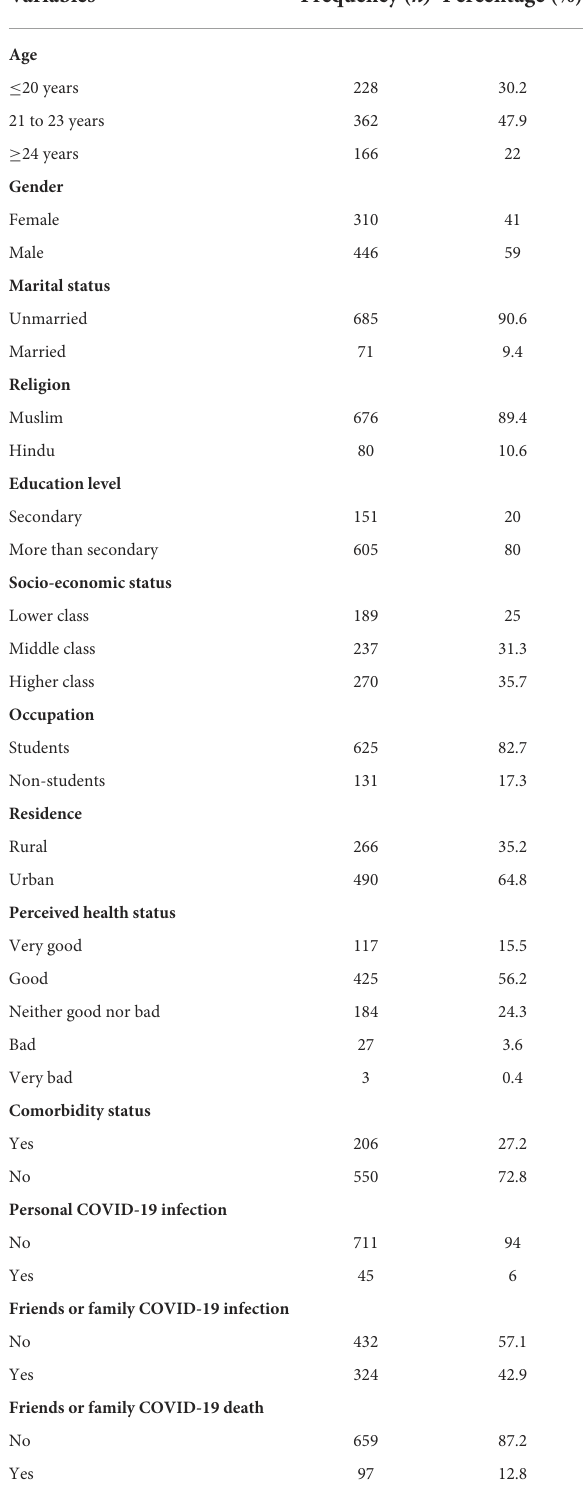
TABLE 1 Distribution of the sociodemographic variables of the respondents.